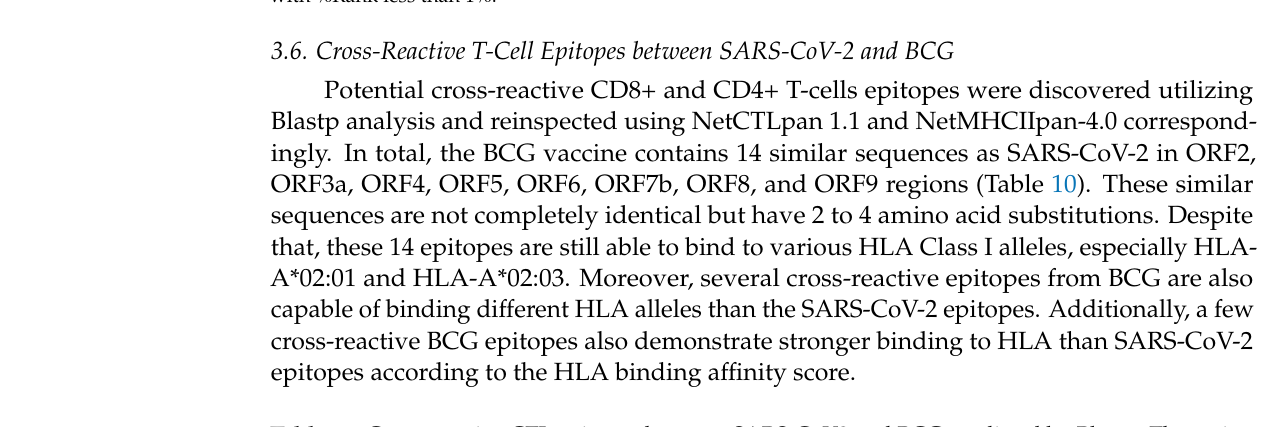
Table 10. Cross-reactive CTL epitopes between SARS-CoV2 and BCG predicted by Blastp. The amino acid substitution is indicated by underlining and TCR contact residue (residue 3–8) is indicated by bold font. n.b. indicates that peptide was predicted as a non-binder to HLA